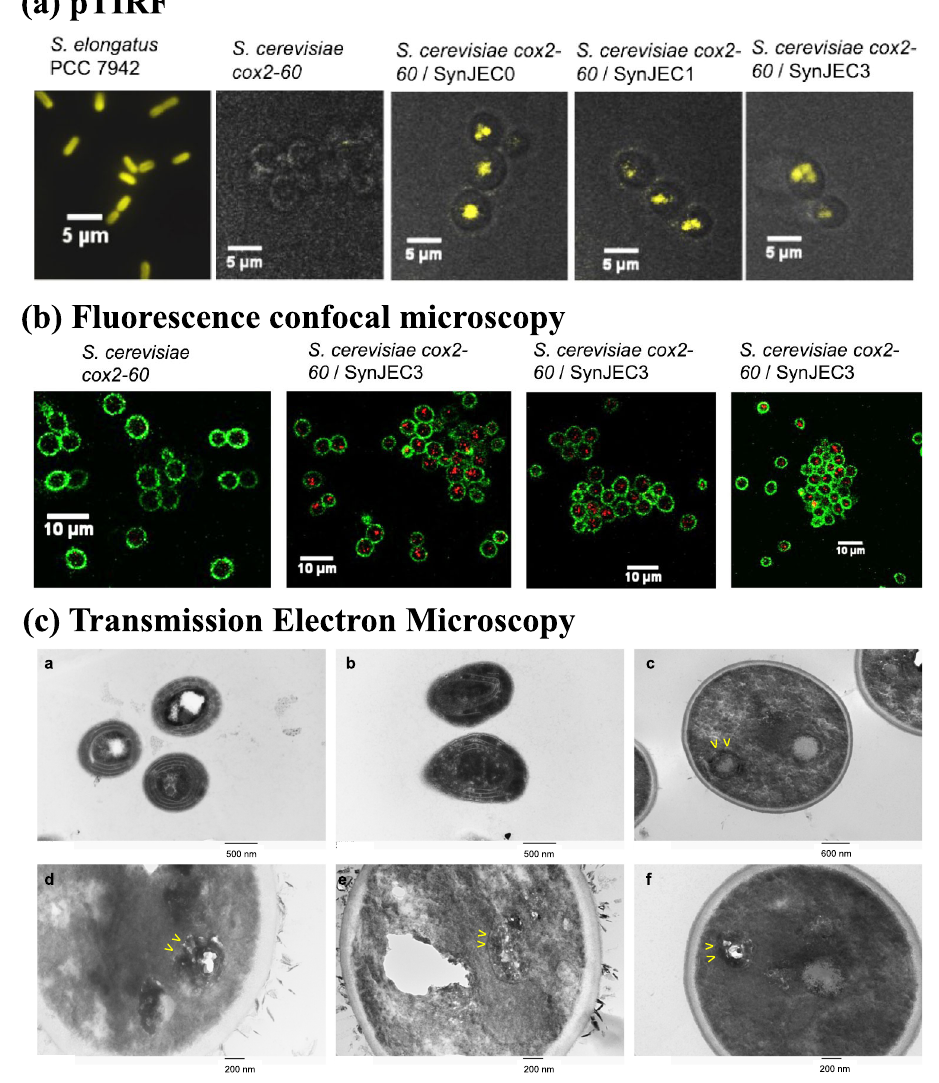
Fig. 4 Imaging intracellular endosymbiont Synechococcus by fl uorescent microscopy. a pTIRF microscopic images of Synechococcus cells, control yeast cells, and chimeric cells that were grown under selection conditions (Ex. = 561 nm; Em. = 653/95 nm). Panels are merged images of pTIRF (yellow) and bright fi eld microscopy (gray). The experiment was repeated three times independently with similar results. b Fluorescence confocal microscopy images of control yeast cells and chimeric cells, which were grown under selection conditions. The yeast cell wall was stained with Con A-FITC (green, Ex. = 488 nm; Em. = 510/20 nm) and the presence of cyanobacteria was monitored by cyanobacterial fl uorescence (red, Ex. = 561 nm; Em. = 650/20nm). Based on these images, it is possible that multiple cyanobacterial cells could be present in some of the yeast cells. The experiment was repeated three times independently with similar results. c Panel a and b are cyanobacterial samples imaged by Transmission Electron Microscopy (TEM) and Panels c – f are fusions imaged by TEM. Yellow arrows show characteristic cyanobacterial structures within the cytoplasm of the yeast cells. The experiment was repeated twice independently with similar